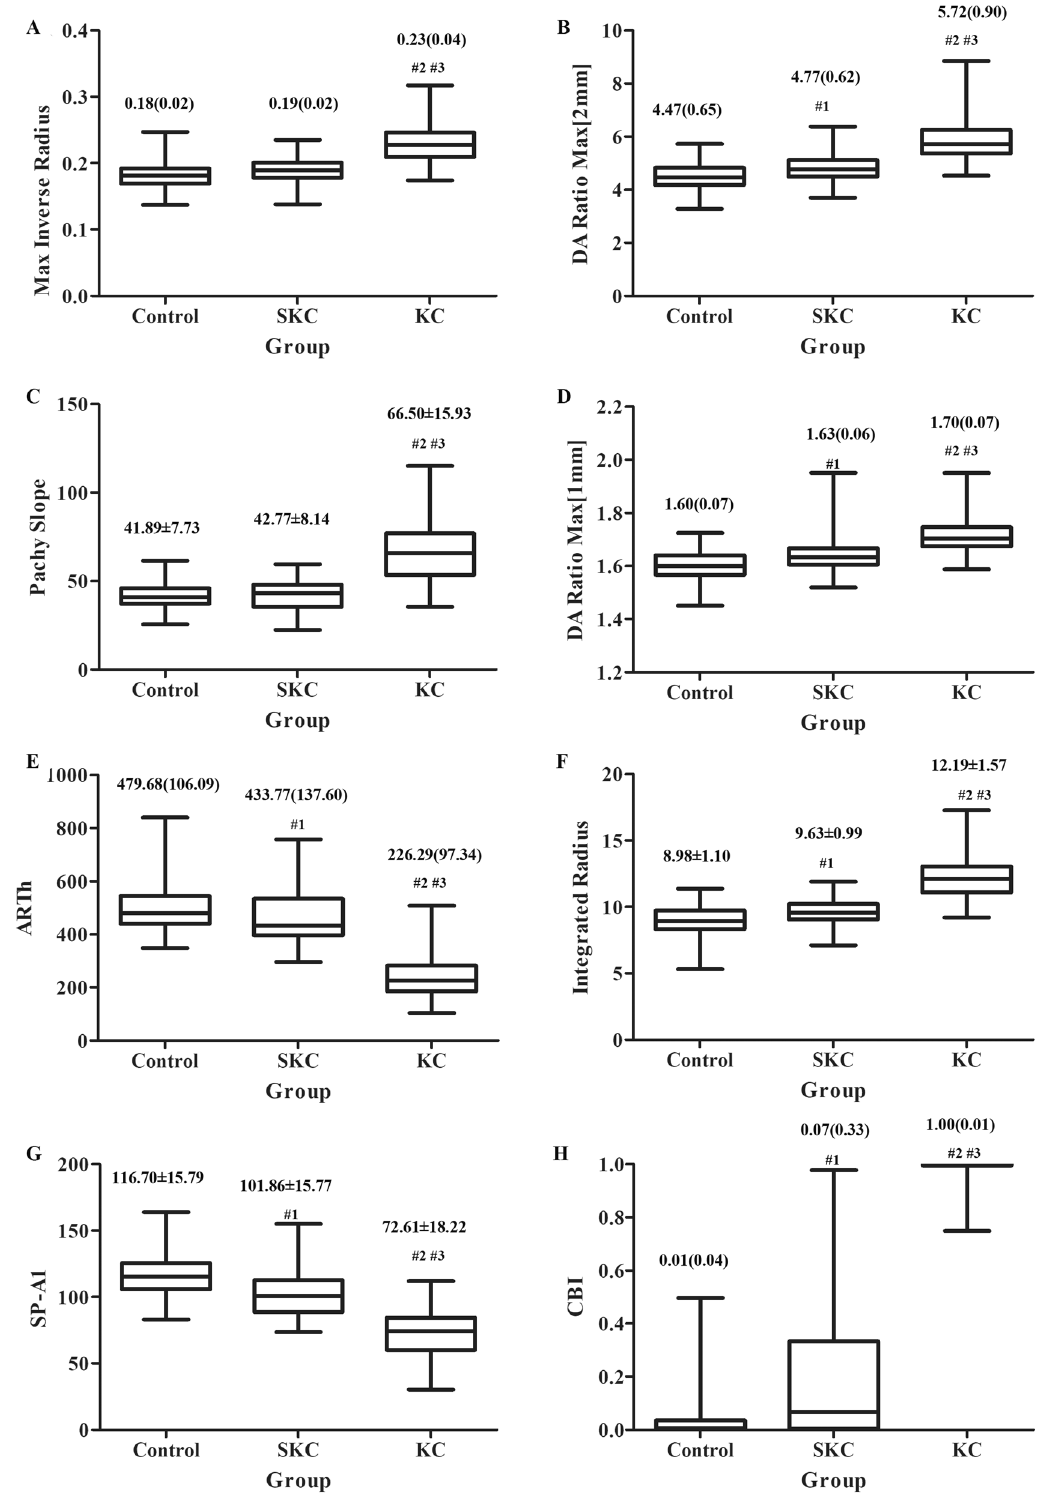
Figure 2. The box plot for new variables measured by Corvis ST ( #1 , P < 0.05 for SKC vs control; #2 , P < 0.05 for KC vs control; #3 , P < 0.05 for KC vs SKC). ( A ) Max inverse radius; ( B ) DA ratio max (2 mm); C, Pachy slope; ( D ) DA ratio max (1 mm); ( E ) ARTh; ( F ) integrated radius; ( G ) SP-A1; H,